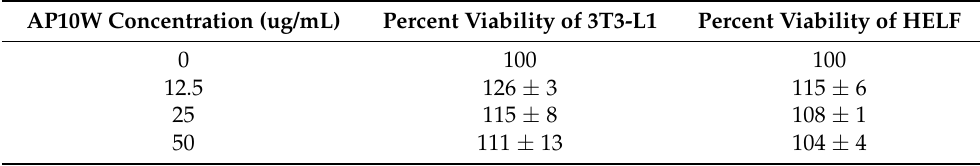
Table 1. The percent viability of 3T3-L1 cells and HELF cells incubated with different concentrations of AP10W. Data were expressed as means ± SD (n = 3) from three independent experiments.